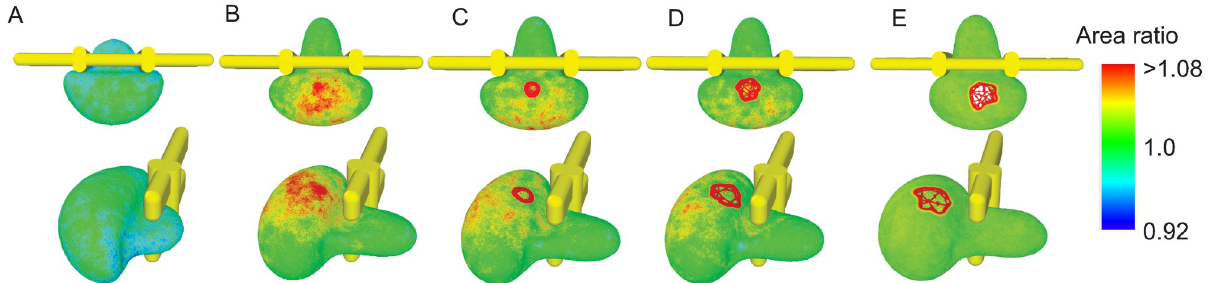
Fig 5. Five successive snapshots of an RBC with surface area of 110 μ m 2 and cell volume of 90 μ m 3 attempting to squeeze through IES at a pressure gradient of 10 Pa μ m − 1 (A) top view (B) side view. The RBC ruptures due to excessive local area expansion. The color contours show the local values of the area expansion ratio. Area ratio > 1 indicates expansion whereas area ratio < 1 indicates compression.